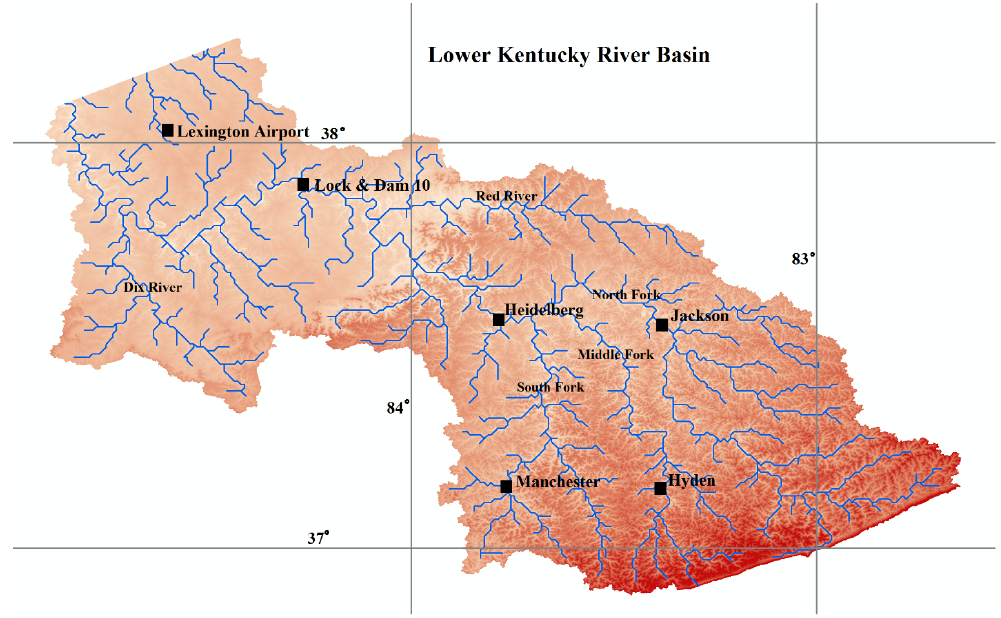
Figure 1. Map of Lower Kentucky River Basin.